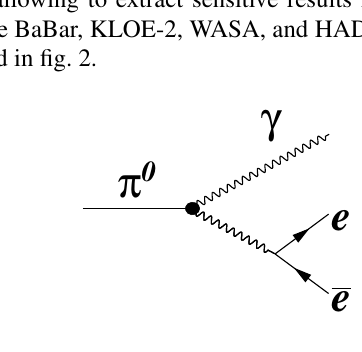
production of a lepton pair via a virtual photon. Fig. 3 shows the decay of pion into a real and a virtual photon, which decays into a lepton pair.